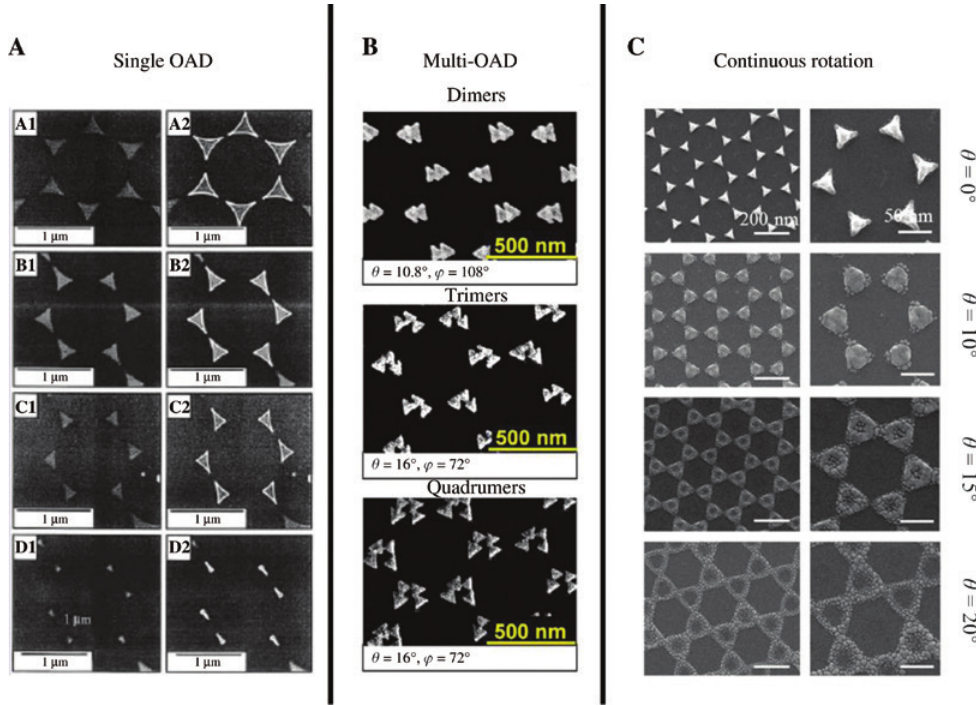
Figure 10: SEM images of the nanotriangles fabricated by SSL. (A) SEM images of triangular NPs and images with simulated geometry superimposed, respectively. (A1, A2) θ = 10 ° , ϕ = 28 ° , (B1, B2) θ = 20 ° , ϕ = 2 ° , (C1, C2) θ = 26 ° , ϕ = 16 ° , and (D1, D2) θ = 40 ° , ϕ = 2 ° [52]. All samples are Cr deposited onto Si (111) substrates. (B) SEM images of the touching triangular dimers, trimers, and quadrumers fabricated by two, three, and four OADs, respectively. The evaporation and rotation angles θ and ϕ are depicted below each image [53]. (C) SEM images of the triangular NPs fabricated by GLAD with continuous rotation at θ = 0 ° , 10 ° , 15 ° , and 20 ° , respectively